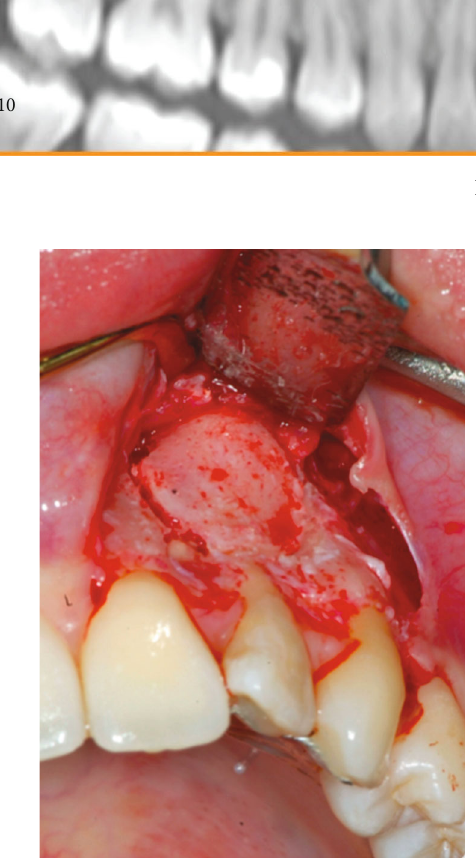
Figure 4: Preparation of the fl ap.